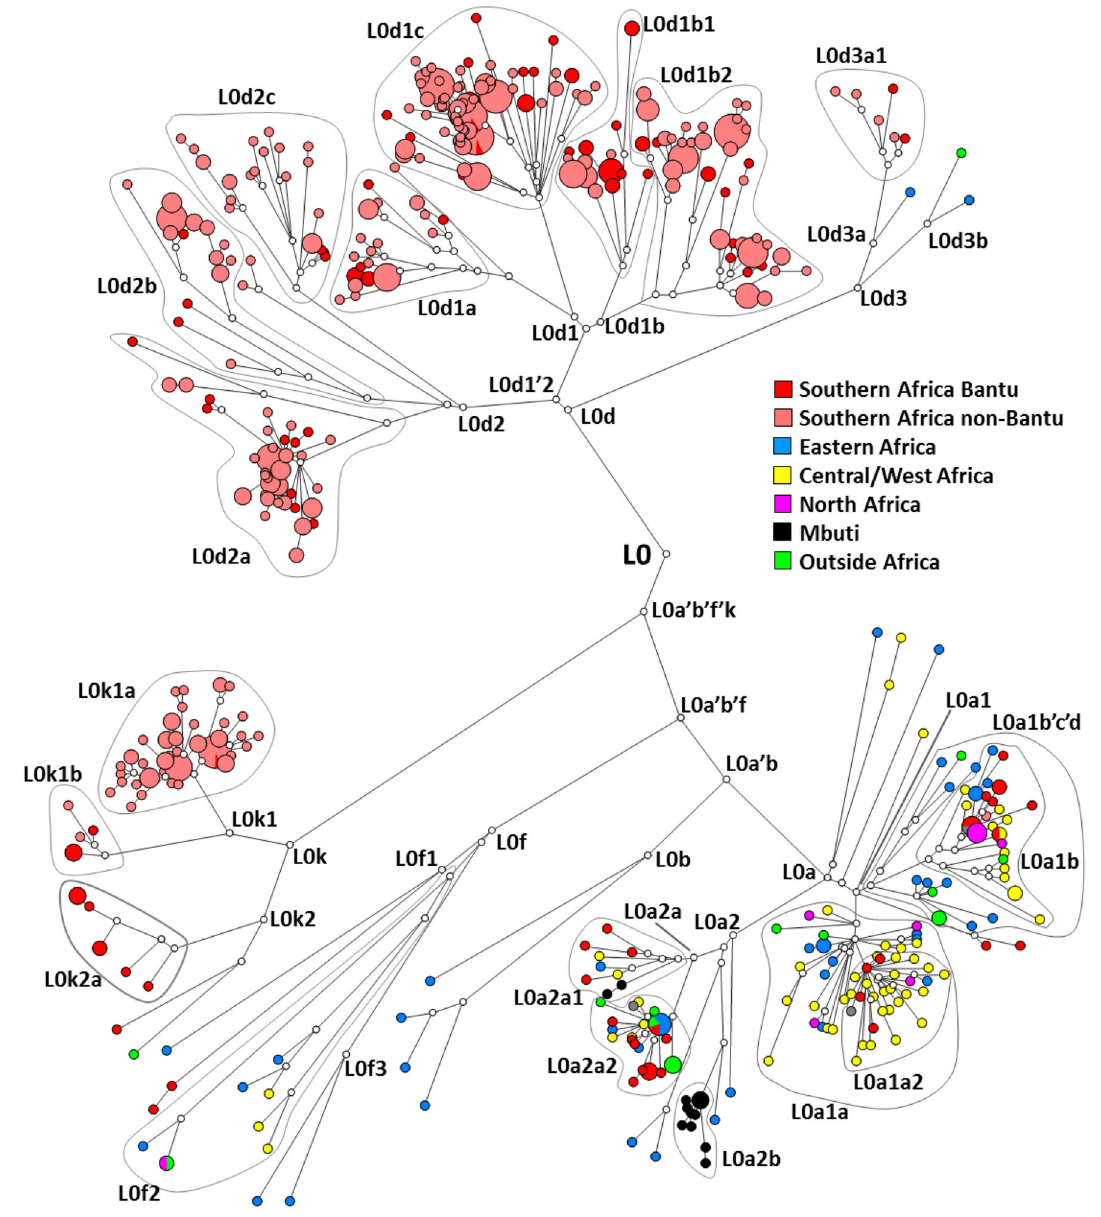
Figure 2. Tree of haplogroup L0 sequences generated using the Network software. The colours indicate the geographic origin of each